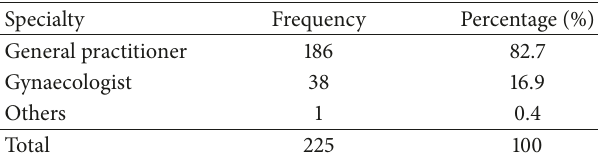
Table 2: Indicated effect of exogenous testosterone on sperm count